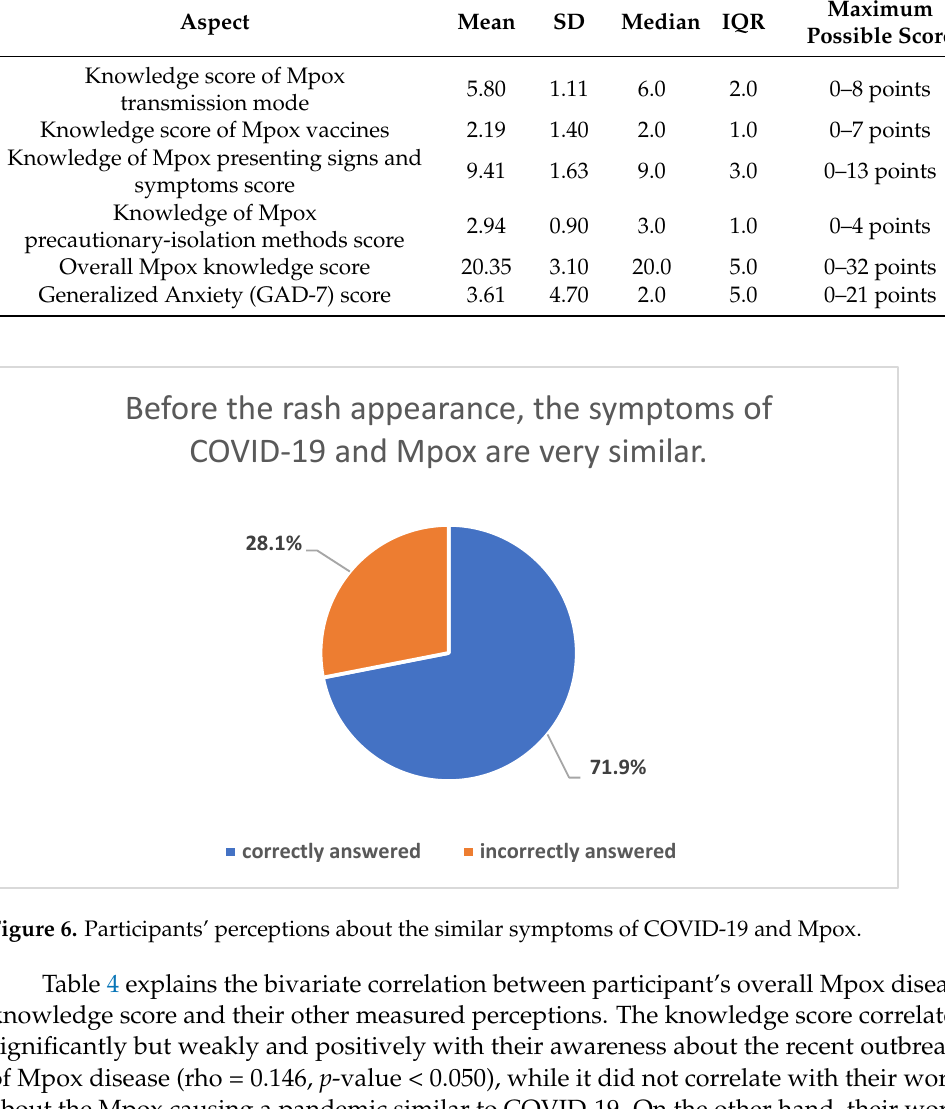
Table 3. Participants’ Mpox disease knowledge scores.